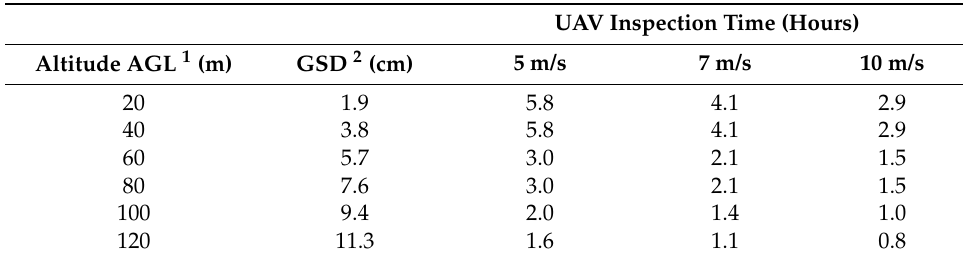
Table 2. Summary of the unmanned aerial vehicle (UAV) flights.